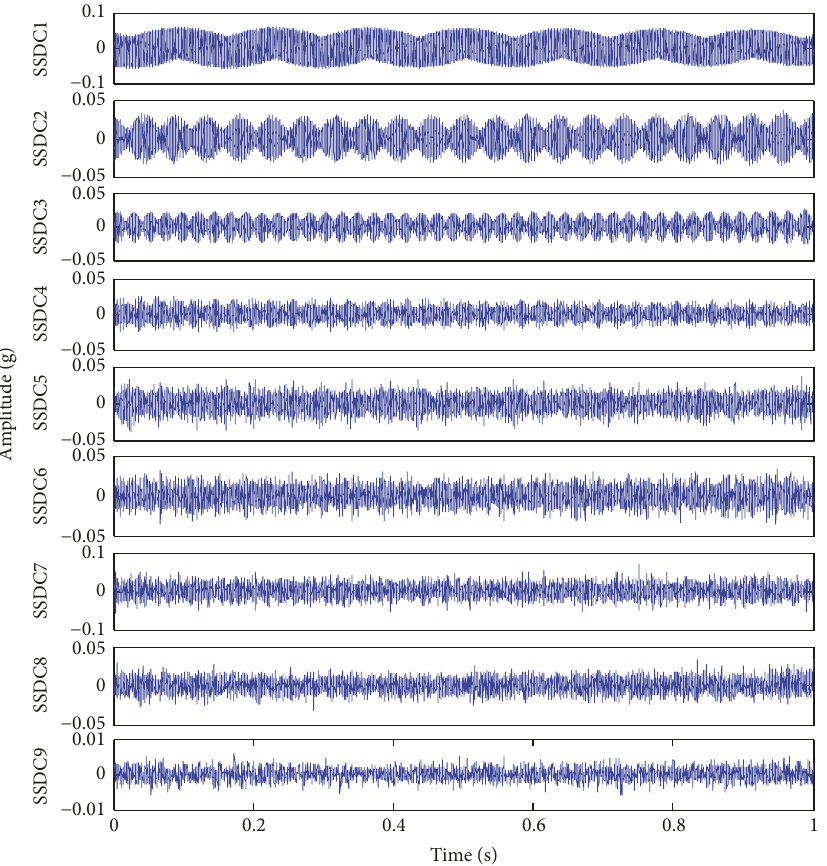
Figure 6: The obtained SSDCs of the vibration signal of degradation state of breakage level